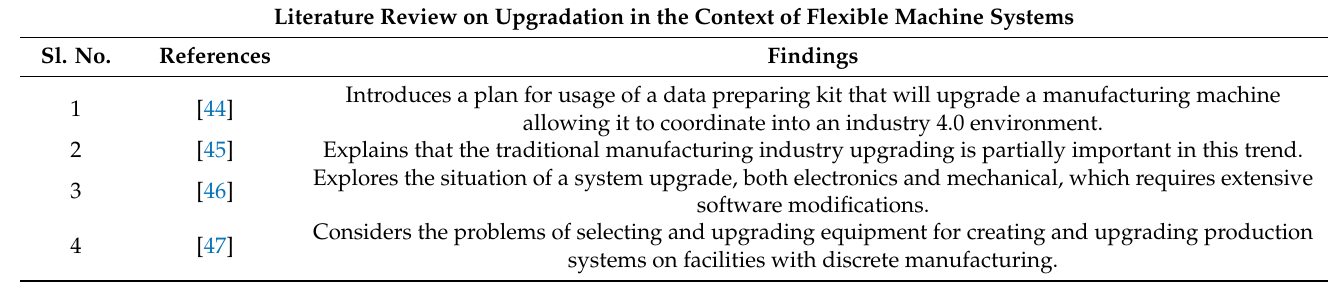
Table 9. Literature review on upgradation related to flexible unit